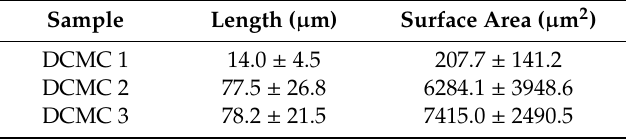
Table 4. Adsorption isotherms parameters.